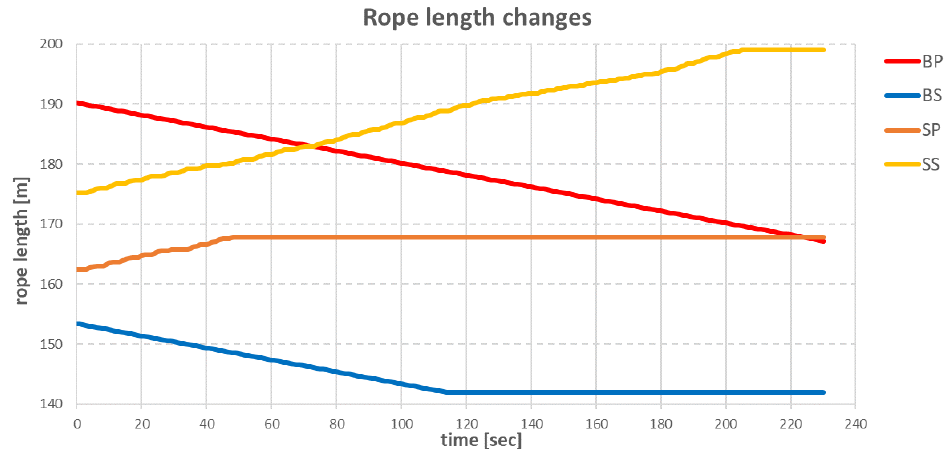
Figure 32. Changes in the length of individual ropes during the operation. The BP and BS anchor winches pulled in the anchor ropes at 0.1 (m/s) evenly over time. Anchor winches SP and SS , in response to the increasing tension, loosened the ropes only when the tension value was above declared value. In this way, the vessel did not gain too much speed. The disadvantage of this solution was that, due to too low speed, the ship was unable to reach the target point.